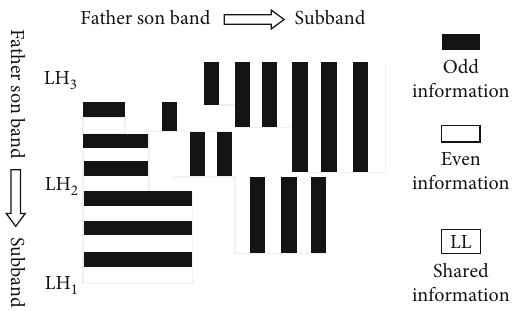
Figure 1: Structure diagram of image